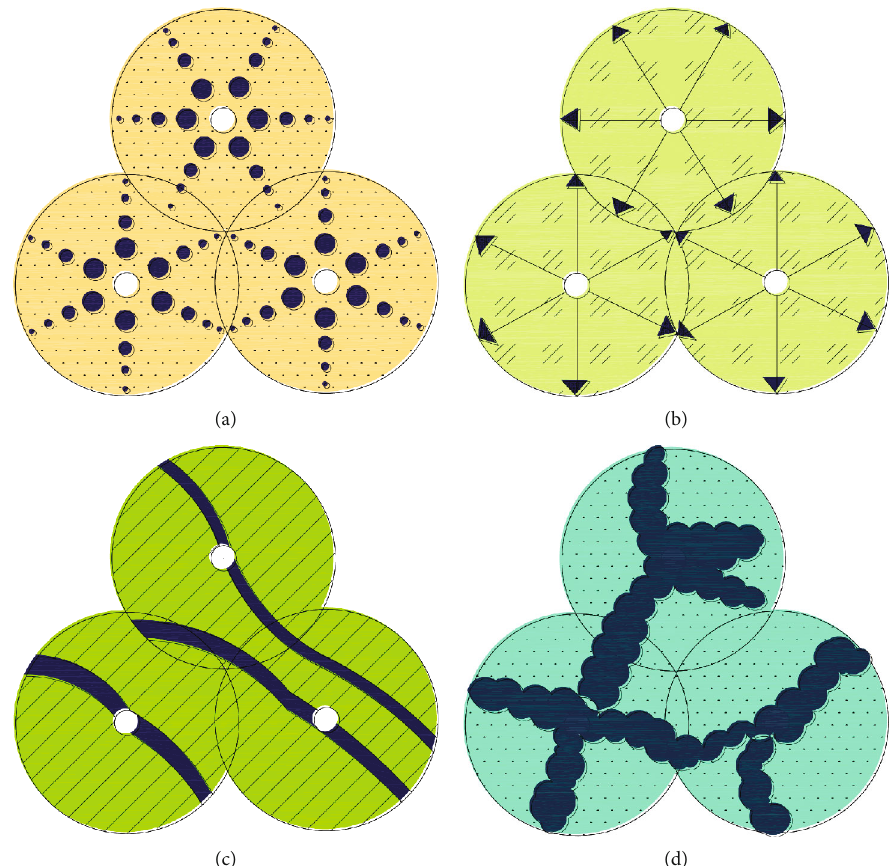
Figure 6: Di ff usion mechanism model of grouting in stratum: (a) permeation di ff usion; (b) splitting di ff usion; (c) fi ssure fi lling; (d) disturbance displacement